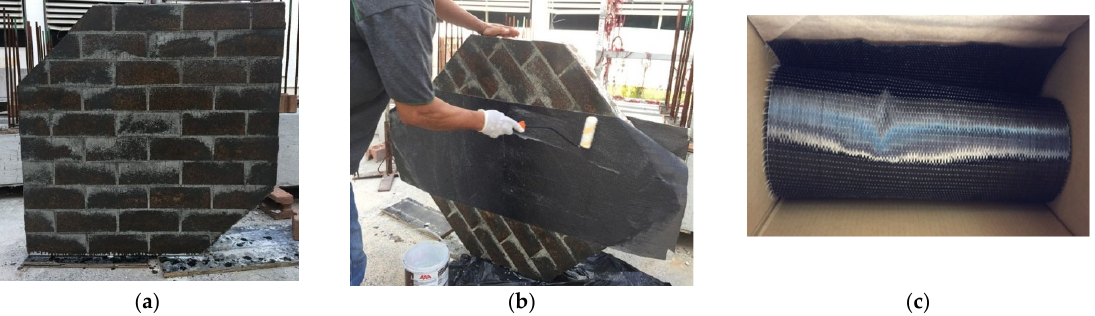
Figure 3. Application of epoxy resin and CFRP: ( a ) Epoxy resin applied to the wall; ( b ) Hand layup method of CFRP application; ( c ) Unidirectional CFRP.